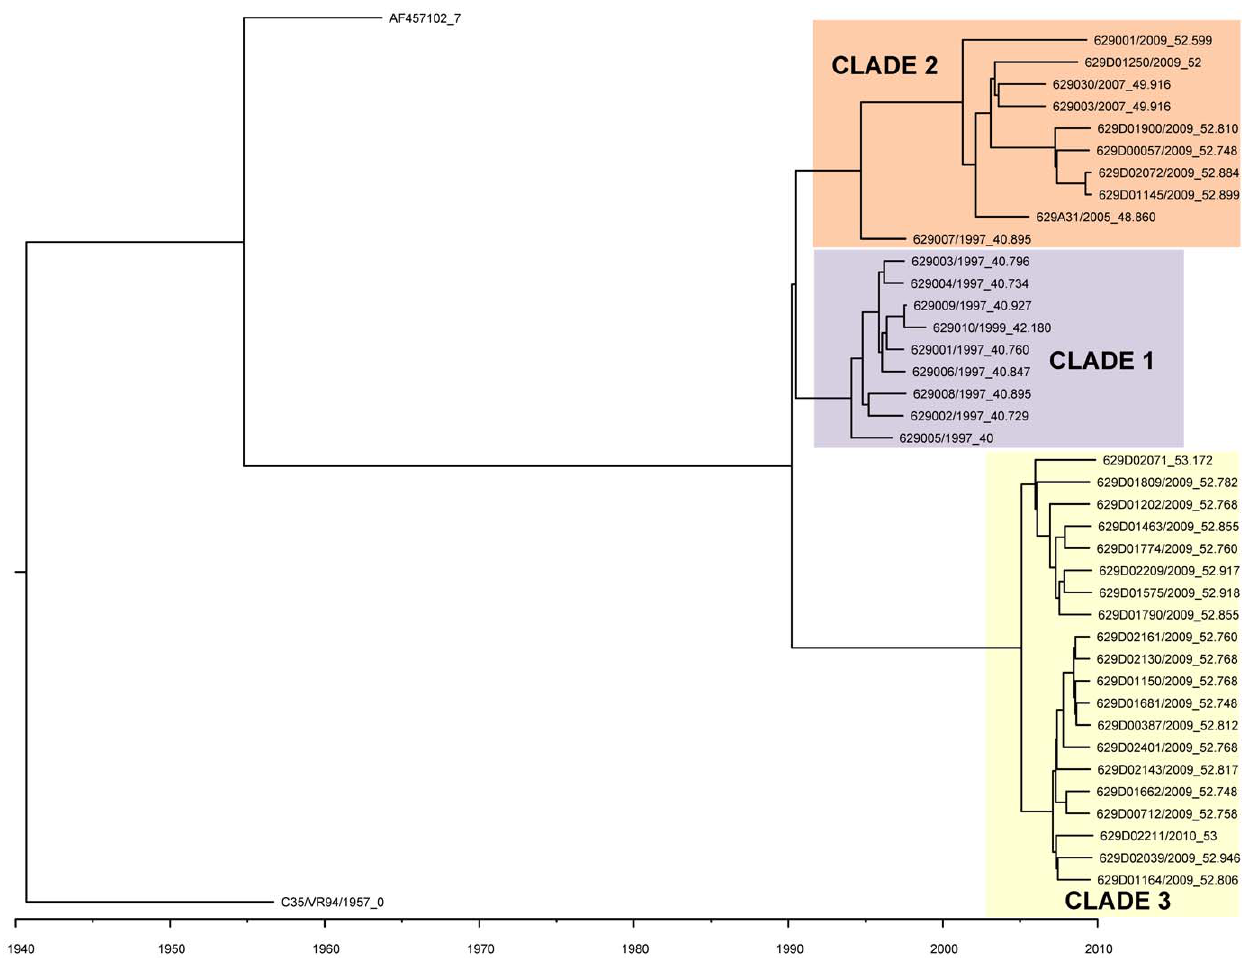
Figure 1. The phylogenetic relationships of the 40 genomes and sequence AF457102 using the BEAST program. The phylogeny of 40 recently sequenced HPIV-1 genomes and one sequence from GenBank (AF457102) was estimated using a Bayesian Markov Chain Monte Carlo (MCMC) method with a strict molecular clock. Strain HPIV-1/c-35/1957 showed the greatest distance from the 39 1997–2010 Milwaukee viruses which is consistent with its isolation time. Colored rectangles (labeled clade 1–3) represent the three clades of the 39 1997–2010 Milwaukee viruses. The sequence from strain HPIV-1/WI/629-007/1997 is a singleton. The scale bar shows the unit for branch age. The numbers following the underscore in each name represent the collection date in number of years since collection date of the oldest HPIV-1 strain. To make the figure more legible identical sequences were removed from the table.